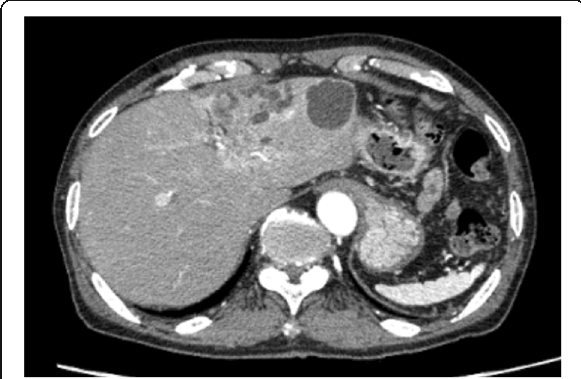
Fig. 1 Computed tomography images showing a tumor in segment 3 (yellow arrow). The peripheral bile duct branch of segment 3 was dilated